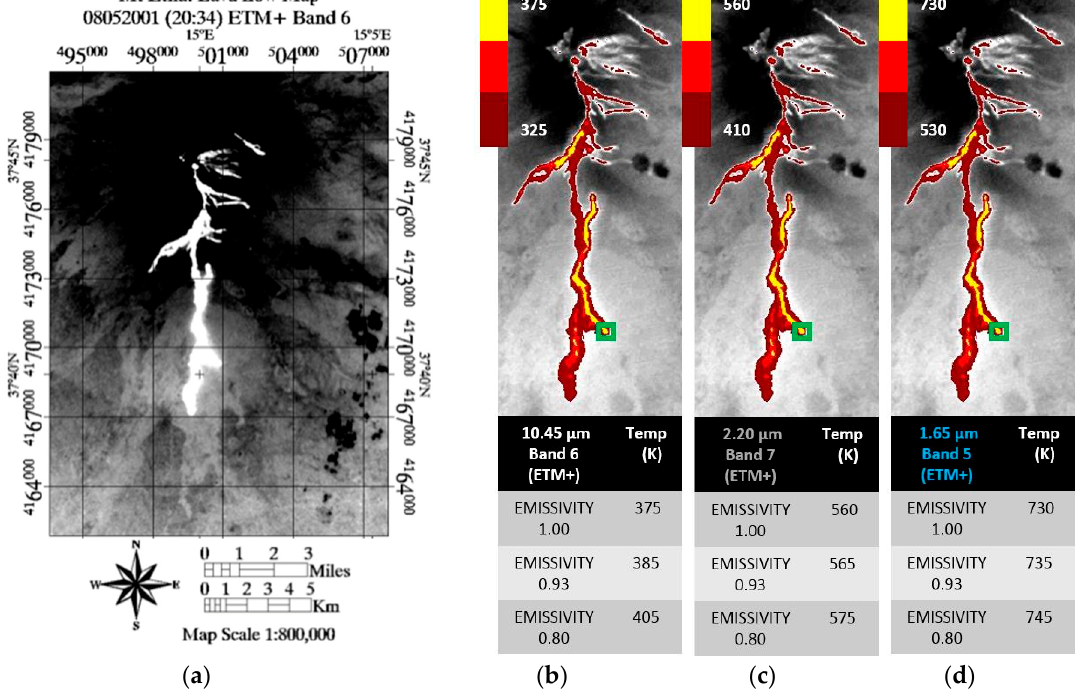
Figure 6. ( a ) Mount Etna high-temperature thermal anomaly scene acquired on 5 August 2001 by Landsat 7 (ETM+); ( b – d ) are all radiant pixel integrated temperatures of the same target area as in a TIR Band 6 and SWIR bands 7 and 5 for emissivity of 1.0; The green square in ( b – d ) marks the location of the pixel (37 ° 39 ′ 28 ″ N 14 ° 59 ′ 48 ″ E) used to derive temperature with emissivity variation given below ( b – d